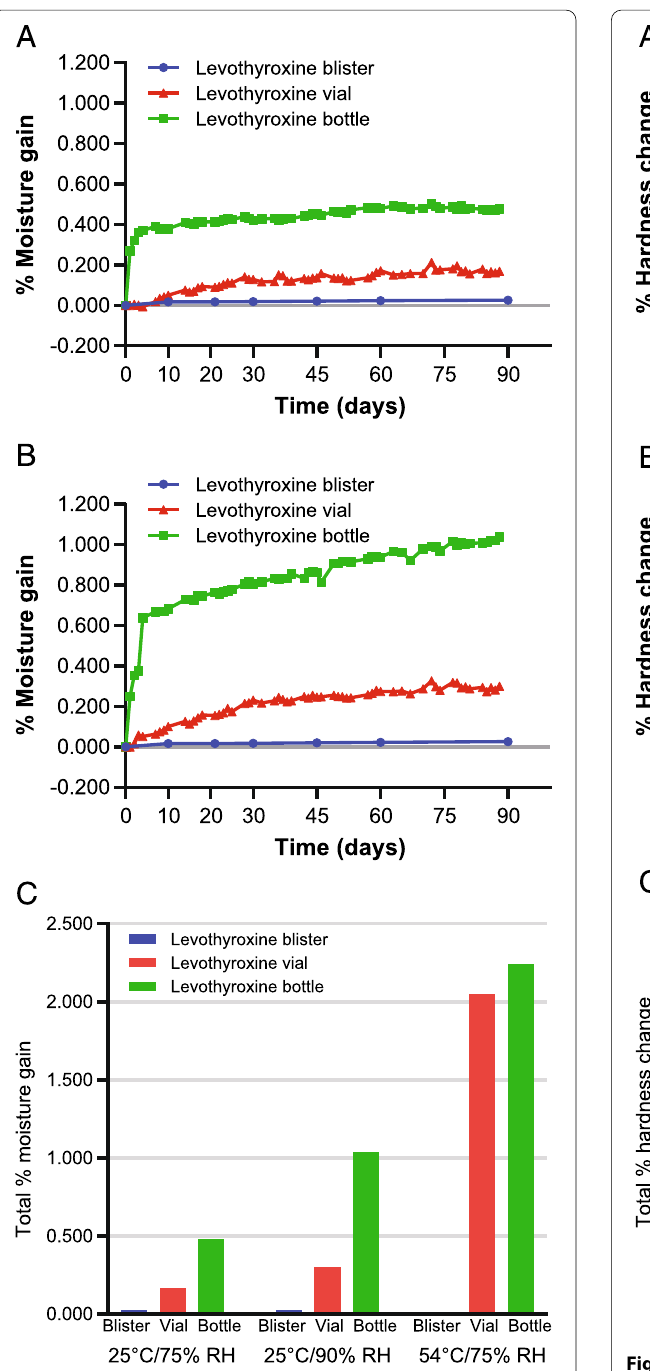
Fig. 1 Moisture gain of levothyroxine tablets. A Percent moisture gain over time: 25 °C/75% RH. B Percent moisture gain over time: 25 °C/90% RH. C Total percent moisture gain under 90-day patient use or 2-day shipping conditions. Abbreviation: RH, Relative humidity